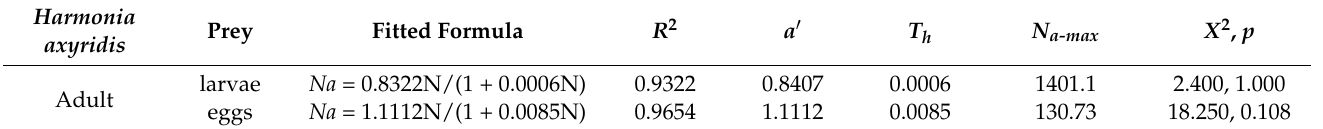
Table 2. Parameters of functional response of Harmonia axyridis preying on Spodoptera frugiperda